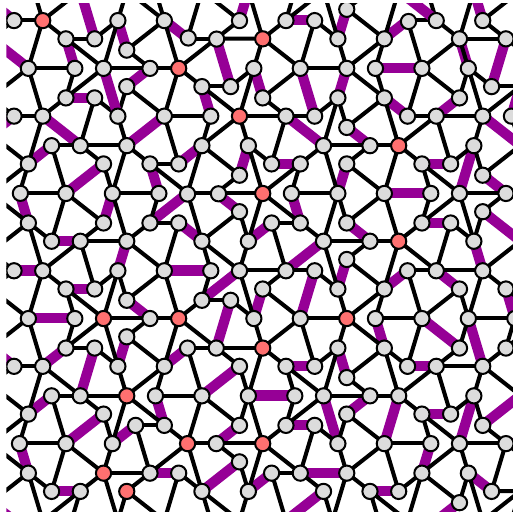
FIG. 15. A maximum matching of the Penrose dart-kite ( P 2 ) tiling in Fig. 14. Monomers are shown in red. All lie on the same bipartite